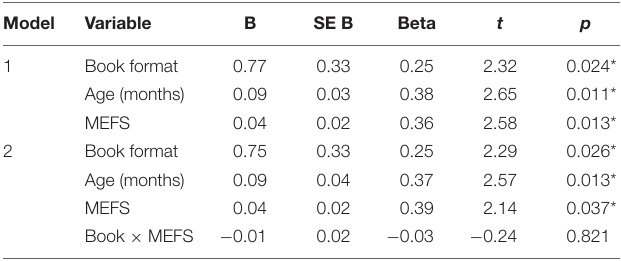
TABLE 4 | Hierarchical regression analysis for the variables predicting recognition of the storybook app content as entered into Model 1 and Model